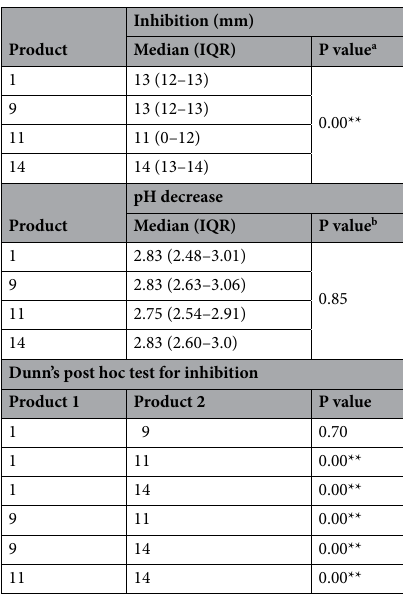
Table 4. Comparison between the inhibition of mixed cultures of dental biofilm from carious lesions and pH reduction of the selected foods. Kruskal–Wallis test and Dunn’s test for multiple comparisons, performed according to data normality and homogeneity. *P < 0.05, **P < 0.01.